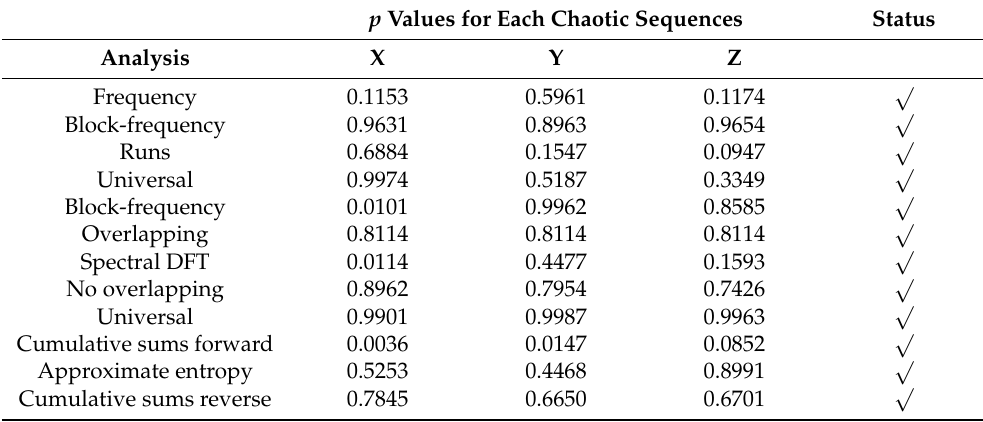
√ means test is passed.